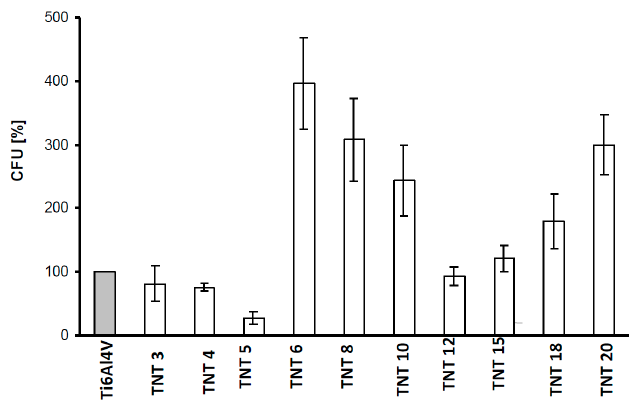
Figure 6. S. aureus ATCC 29213 aggregates/biofilm formation on the surfaces of Ti6Al4V alloy foil modified by TiO 2 nanotubes (TNT) tested by the colony-forming units (CFU) method. The results are presented as mean percentage ± standard deviation (S.D.) of S. aureus CFU reclaimed after 24 h from Ti6Al4V alloy biomaterials modified by TiO 2 nanotubes with different diameters (TNT), in comparison to bacterial CFU recovered from control (unmodified) biomaterial (Ti6Al4V) considered as 100%. Two independent sets of experiments were prepared, each in duplicate.